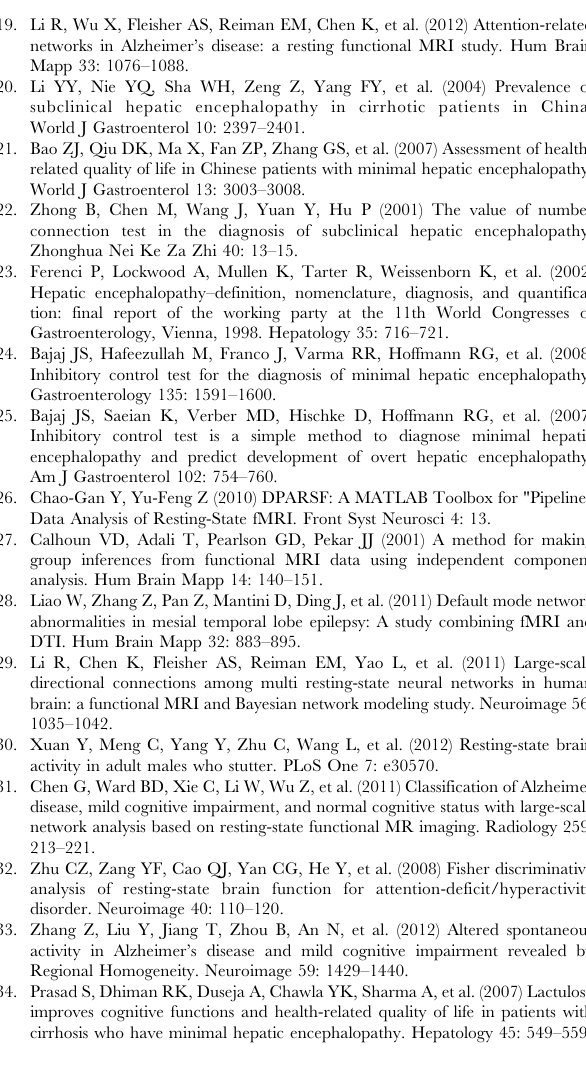
Figure S1 The masks of three attention-related net- works. DAN, dorsal attention network; VAN, ventral attention network; DMN, default mode network.